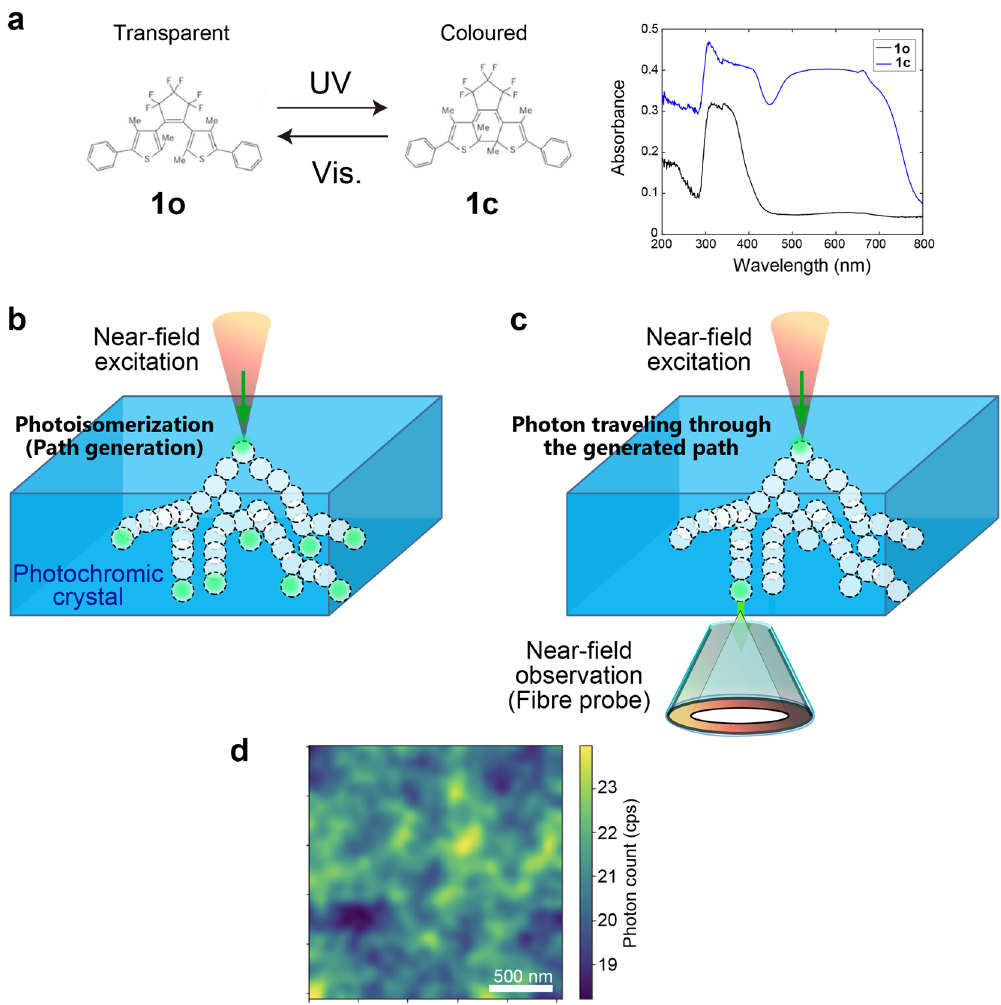
Figure 1. Nanoscale photochromism by near-field optics. ( a ) Transparent and coloured states of diarylethene and their absorption spectra. ( b ) Local near-field light excitation at the surface of the photochromic material to generate photoisomerization at the nanometre scale. Complex pathways are developed. ( c ) Once th pattern is formed, the local optical excitation travels through the generated path. ( d ) The output position of the photons was observed using scanning near-field optical microscopy. Adapted from Uchiyama et al. 18 , Sci. Rep. 10,